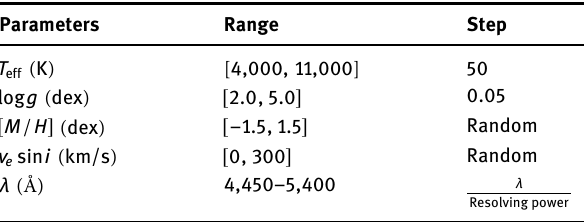
Table 1: Ranges of the parameters used for the calculation of the training